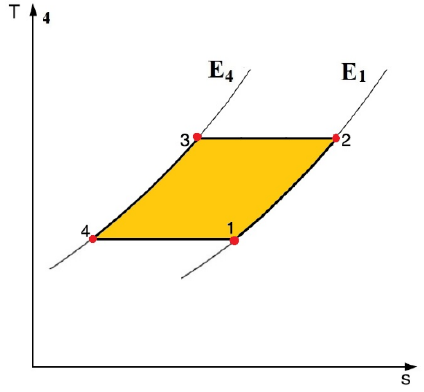
Figure 3. The four processes of the Ericsson cycle for electrocaloric cooling.